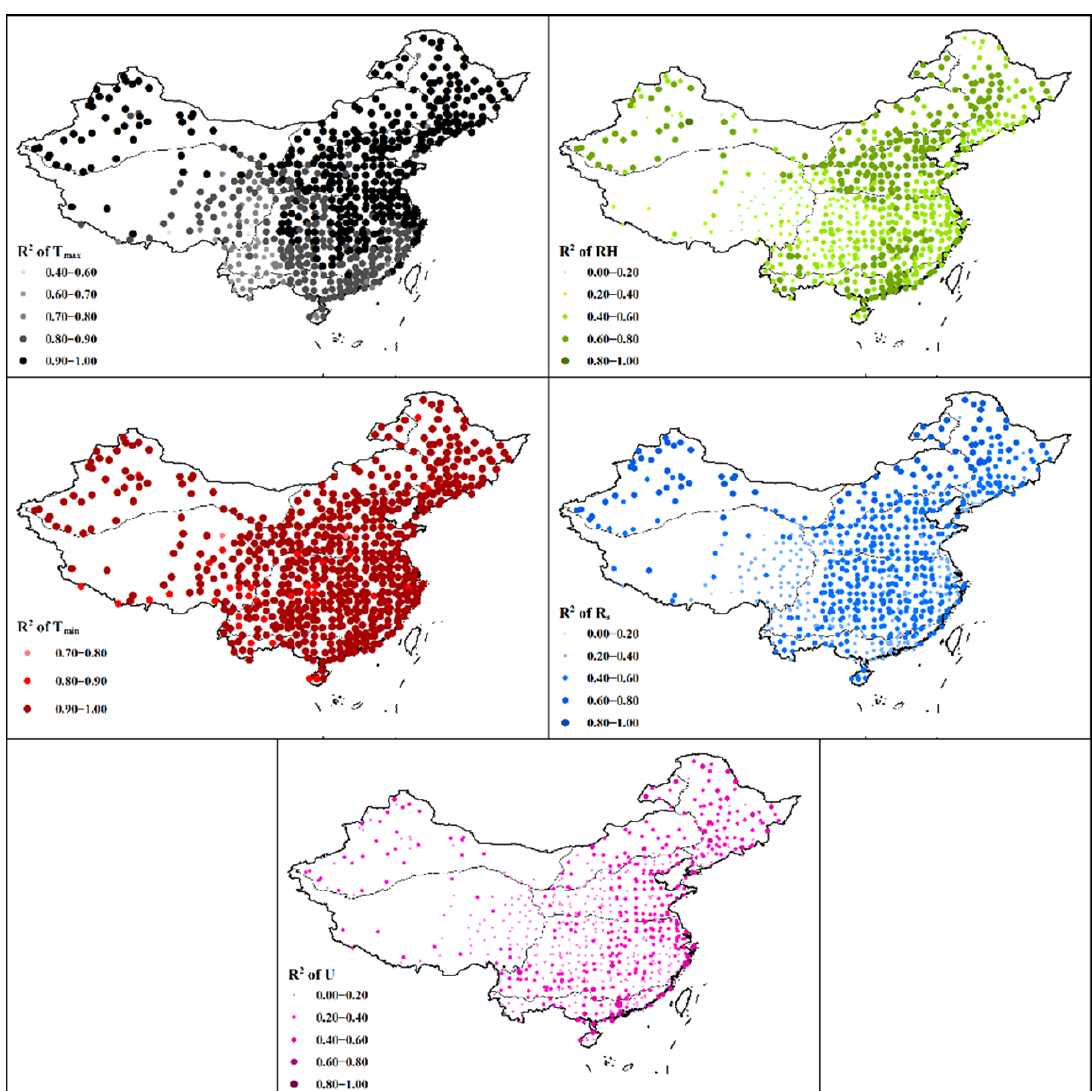
Figure 4. R 2 values of the five meteorological factors of in all stations.